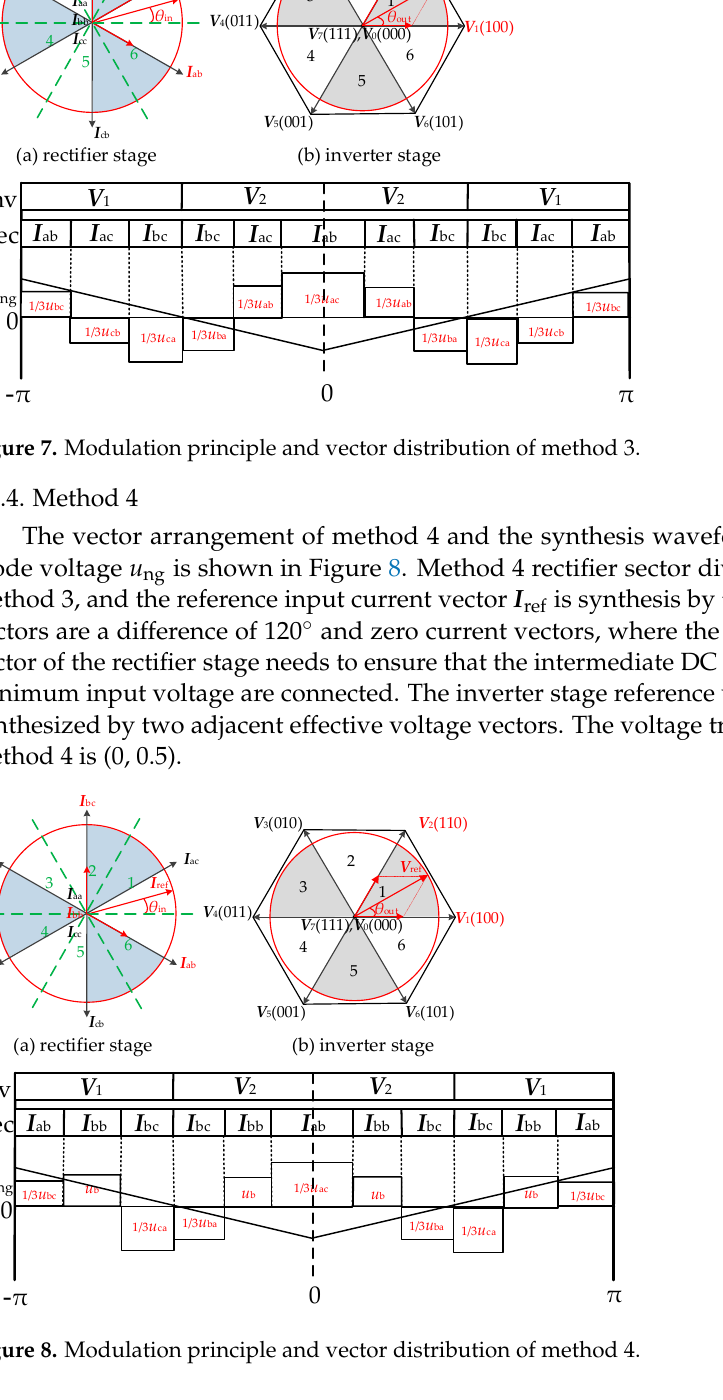
Figure 6. Modulation principle and vector distribution of method 2.